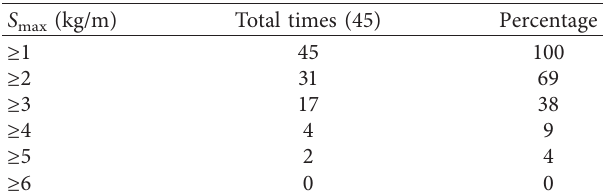
Table 10: Distribution of percentages of prediction index S ( Φ 42mm) during the test.